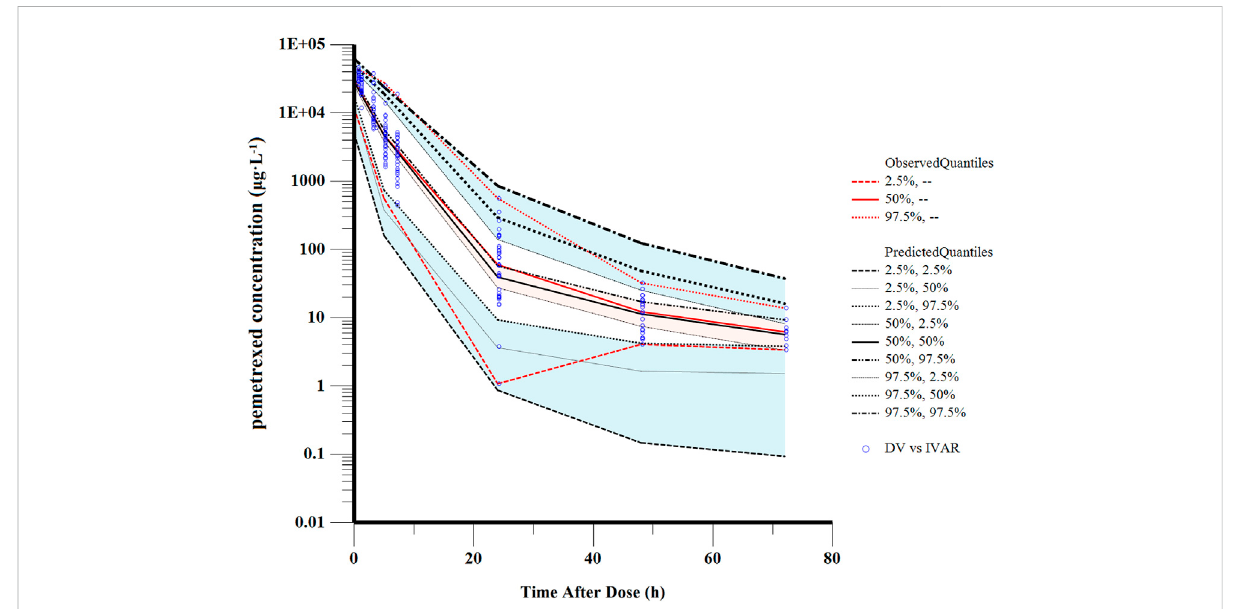
FIGURE 4 Visual predictivecheckofthe fi nalmodel. The solidredlinerepresentsthemedianobserved concentrations. Thesolidblack linerepresents the median simulated concentrations. The 2.5th and 97.5th percentiles of these concentrations are presented with dashed lines.